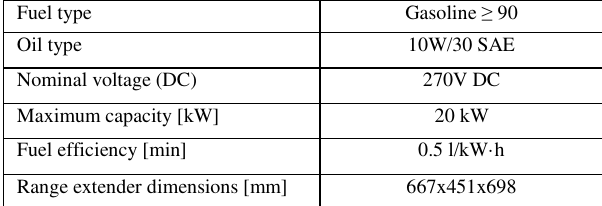
Table 1. Technical characteristics of the Range Extender